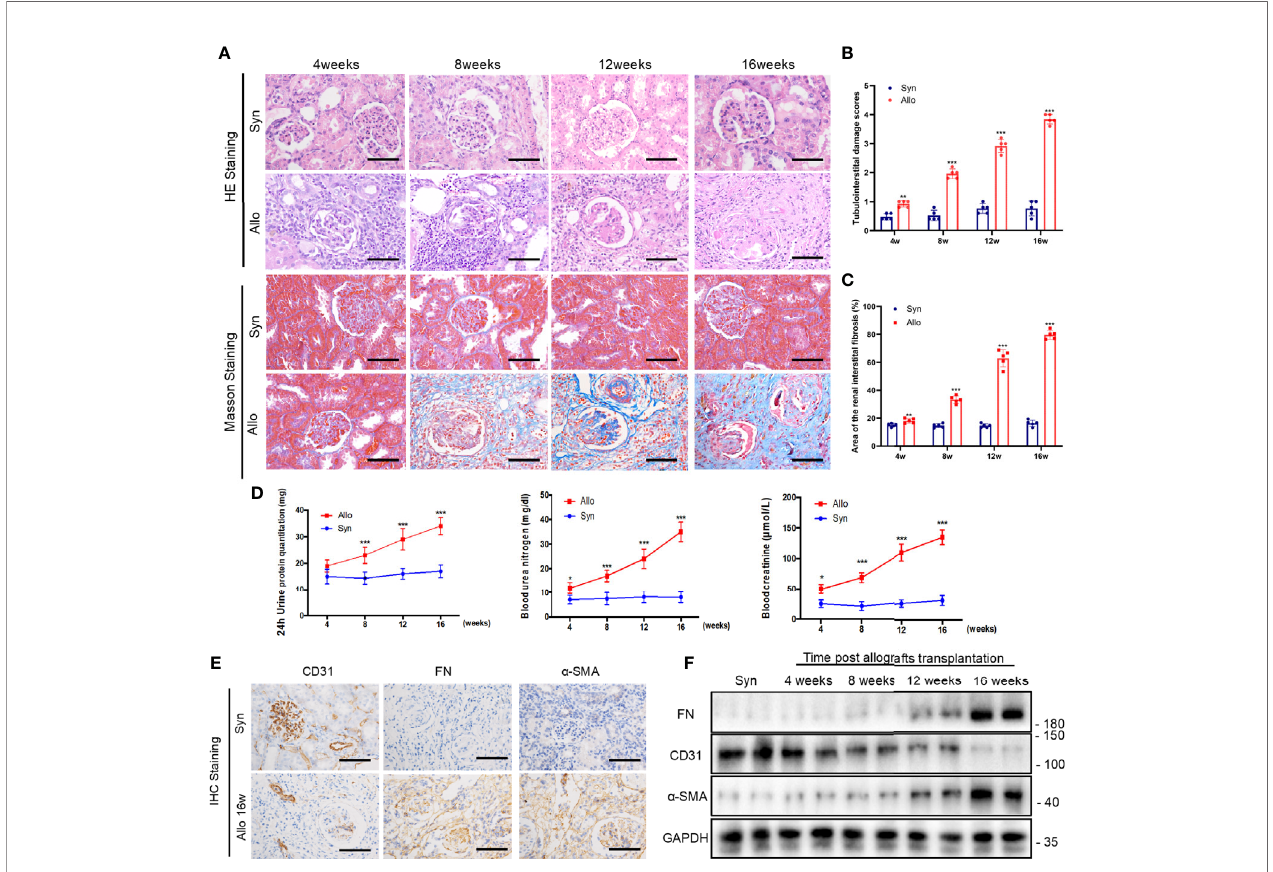
FIGURE 5 | Changes of renal interstitial fi brosis, urine protein, renal function and EndMT in chronic rejection rat model. (A) Representative images of HE and Masson ’ s trichrome staining from kidney tissues of syn and allo groups (scale bar: 25 m m). (B) The statistical analyses of tubulointerstitial damage scores in syn and allo group. Data were expressed as the mean ± SD of each group. (n = 5, *** P < 0.001, ** P < 0.01, vs. the same weeks syn group, Student t test.) (C) Semi- quantitative analyses of positive areas of renal interstitial fi brosis were performed from Masson staining assay results. Data were expressed as the mean ± SD of each group (n = 5, *** P < 0.001, ** P < 0.01, vs. the same weeks syn group, Student t test.). (D) Renal function parameters (serum Cr and BUN) and 24h urine protein quantitation in syn and allo group. Values represent the mean ± SD, (n = 5, *** P < 0.001, * P < 0.05, vs. the same weeks syn group, Student t